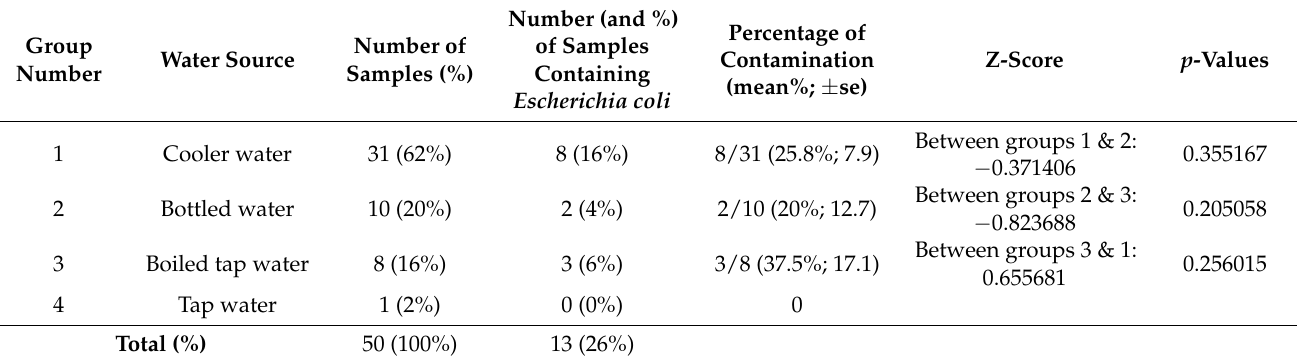
Table 3. Summary statistics on source of water in droppers used for pharmaceutical compounding in Jordanian community pharmacies. The table shows number of samples contaminated with Escherichia coli , mean (%) and standard error (SE). Statistical significance between source groups was inferred using Z-score and the p -values between the groups was reported.